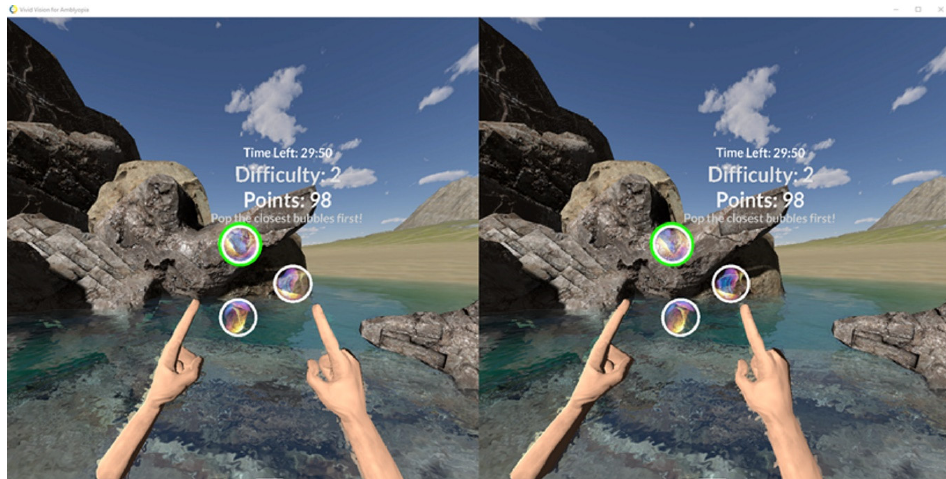
Figure 1. Bubbles game. Patient has to pick circles from the highest disparity continually to the lowest disparity. Different game difficulty levels are used. Both arms can be used by the patient to choose different bubbles.